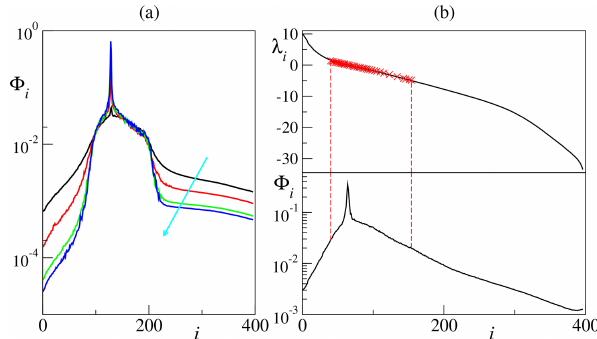
Figure 9. (a) X -projection patterns (cid:56) i for Lorenz 96 with fast- variable forcing ( F f = 6), strong coupling h = 1 and increasing (along the direction of the cyan arrow) values of amplitude sepa- ration, b = 10, 20, 40 and 50. (b) Lyapunov spectrum (top part of panel) and X -projection patterns (bottom part of panel) for Lorenz 96 with no fast-variable forcing ( F f = 0) and standard parameter values, h = 1 and b = c = 10. The red crosses mark the values of the X -restricted spectrum (see Sect. 4 for more details). System size is K = 36 and J = 10 in both